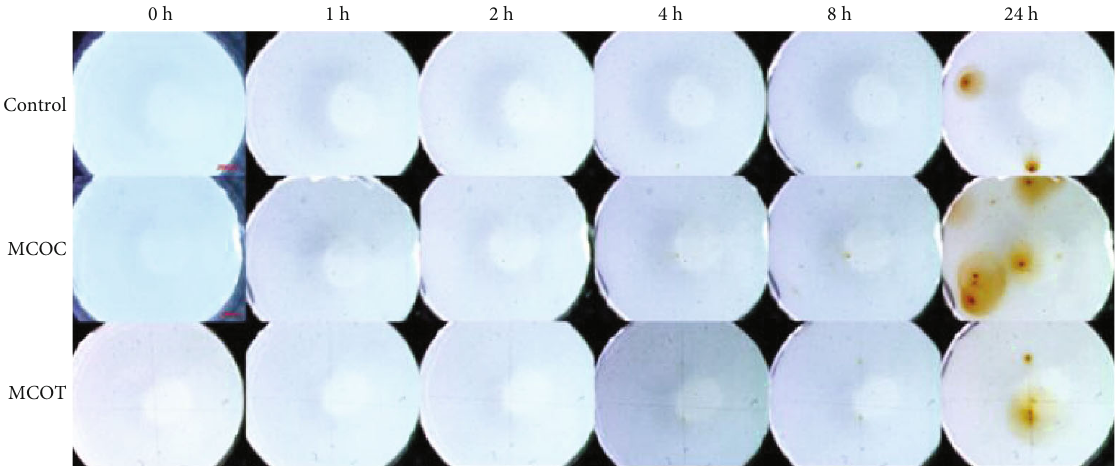
Figure 13: Control system, MCOT system, and MCOC system images up to 24 hours of electrolyte exposure.